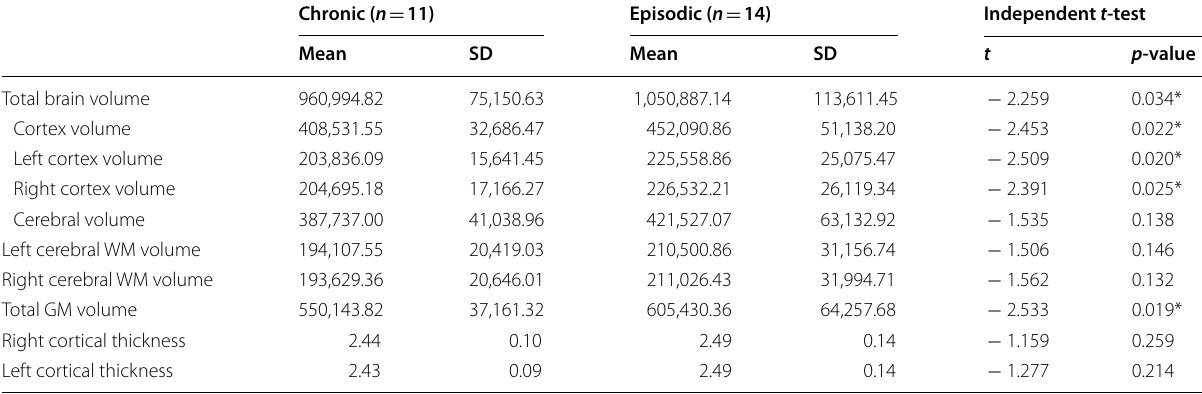
Table 4 Comparison between chronic and episodic migraine patients as regards total brain volumetry (mm 3 ) and cortical